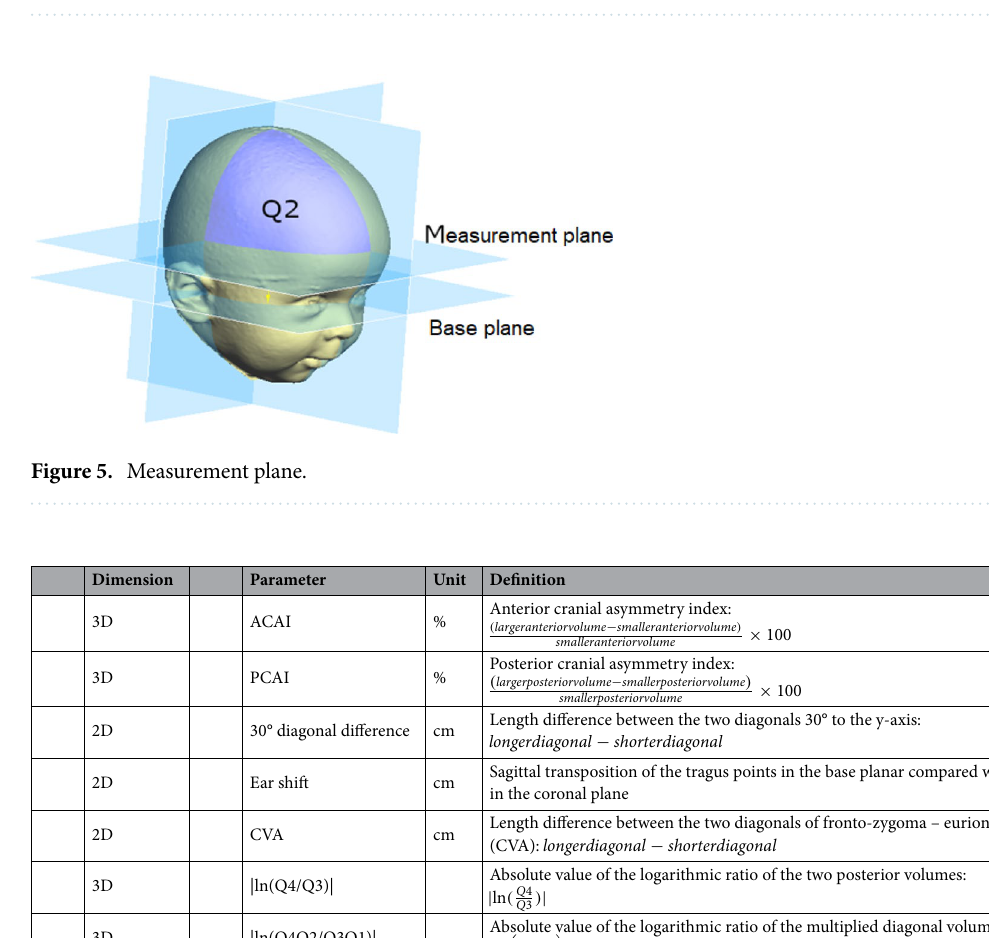
Figure 4. The four volume quadrants.